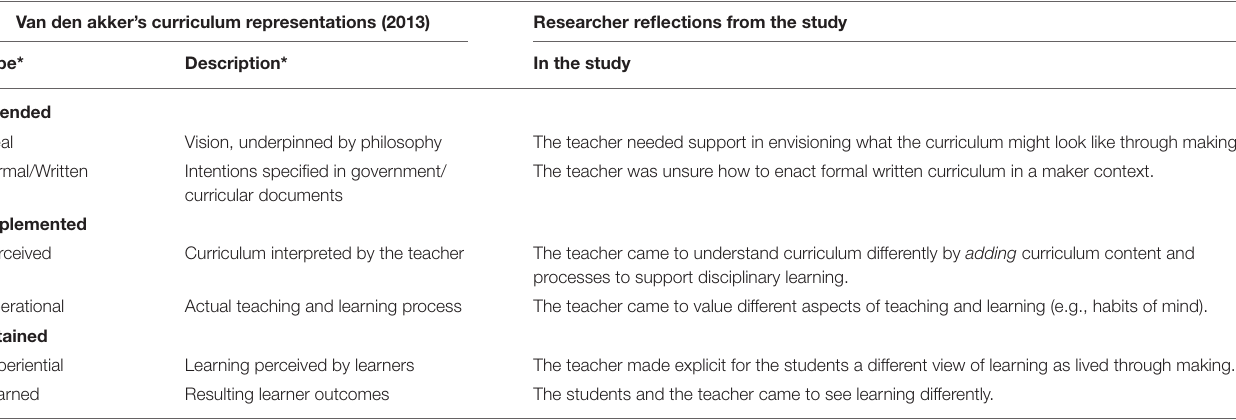
TABLE 7 | Researchers’ reflections on the teacher and students’ notions of representation of curriculum (Becker, 2019). Van den akker’s curriculum representations